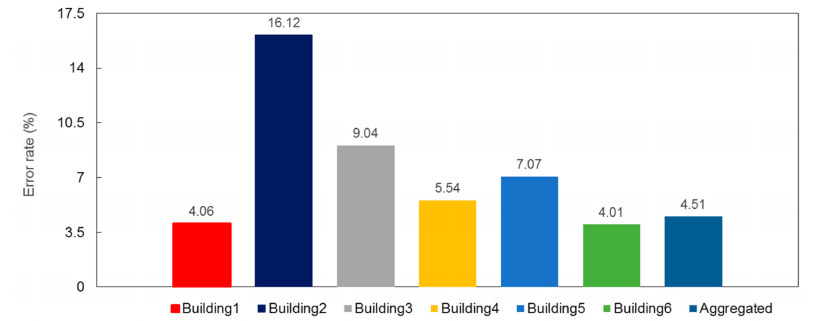
Figure 13. Average percentage error results for winter season.